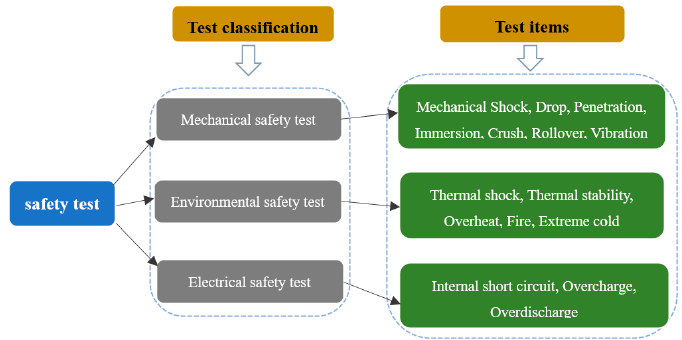
Figure 2. Safety test classification .